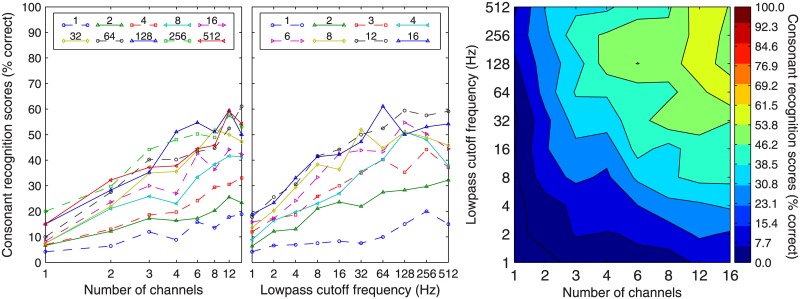
Group mean performance in Korean consonant recognition.Data represent the average of all 11 subjects. In the left panel, consonant recognition scores are plotted as a function of the number of channels, with different lines representing data for different lowpass cutoff frequencies (Hz) as indicated in the figure legend. In the middle panel, consonant recognition scores are plotted as a function of the envelope lowpass cutoff, with different lines representing data for different numbers of channels. In the right panel, contours filled with particular colors represent certain levels of performance (see color bar on the right) as a function of number of channels (abscissa) and lowpass cutoffs (ordinate).